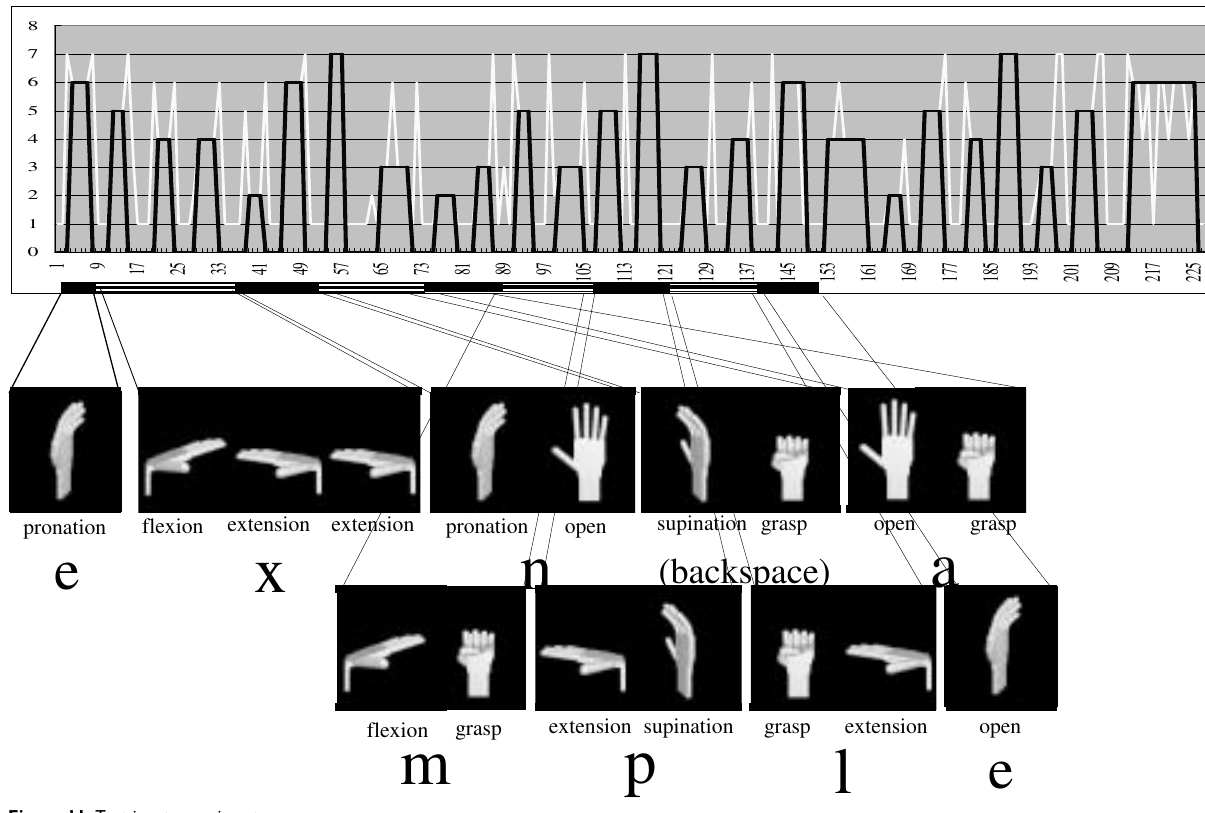
Figure 11 Text input experiment.